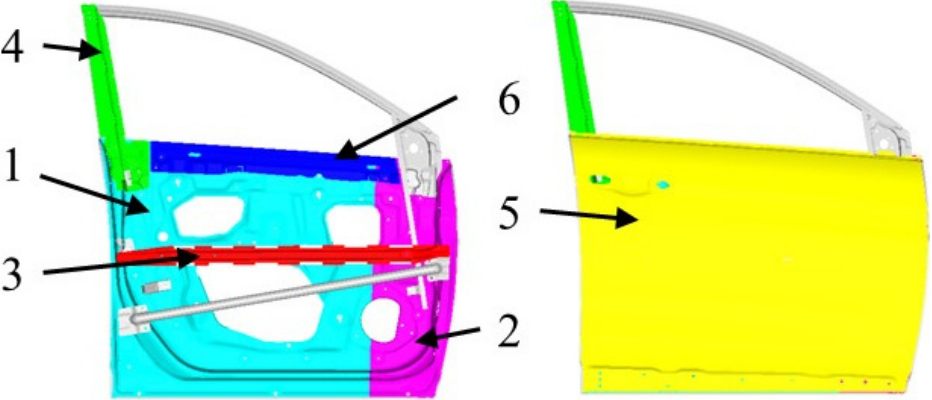
Figure 4. Schematic of door parts: 1: right inner panel, 2: left inner panel, 3: middle reinforcement of inner panel, 4: vertical belt reinforcement, 5: outer panel, and 6: transverse belt reinforcement. Table 3. Material properties of door structure.